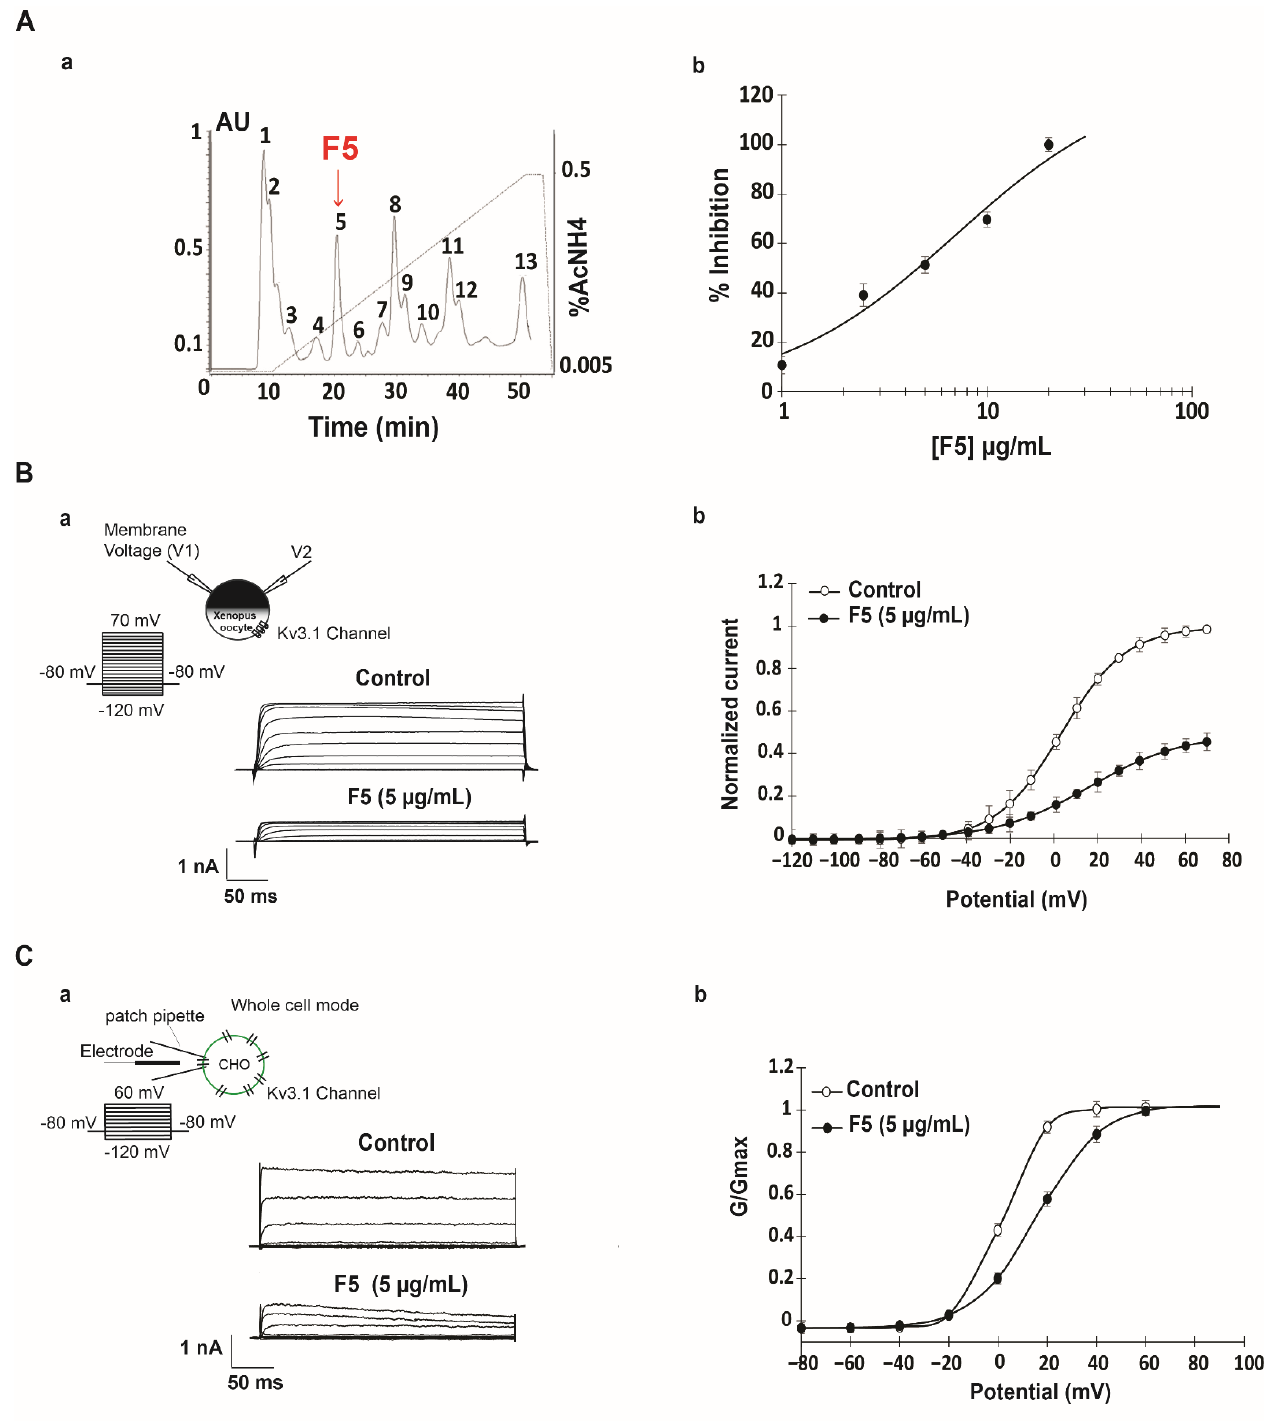
Figure 2. Identification of FPLC subfractions in AahG50 active on Kv3.1 channel. ( Aa ) Purification of AahG50 with FPLC. Seven milligrams of proteins were loaded per run on a cation exchange Resource S column pre-equilibrated with 0.05 M ammonium acetate buffer (pH 6.6). Proteins were eluted with a 40 min linear gradient from 0.05 to 0.5 M ammonium acetate (pH 6.6) at a flow rate of 1 mL/min; absorbance was monitored at 280 nm. ( Ab ) Dose–response curve for the inhibition of Kv3.1 by various concentrations of F5. Current amplitudes were measured at the end of the depolarizing pulse (+70 mV), the percentage of inhibition was plotted against respective concentrations of F5. The curve was fitted by the Hill